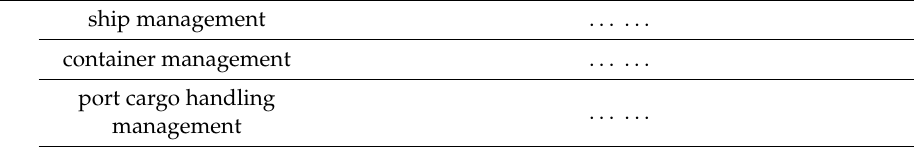
Table 3. The Port Monitoring